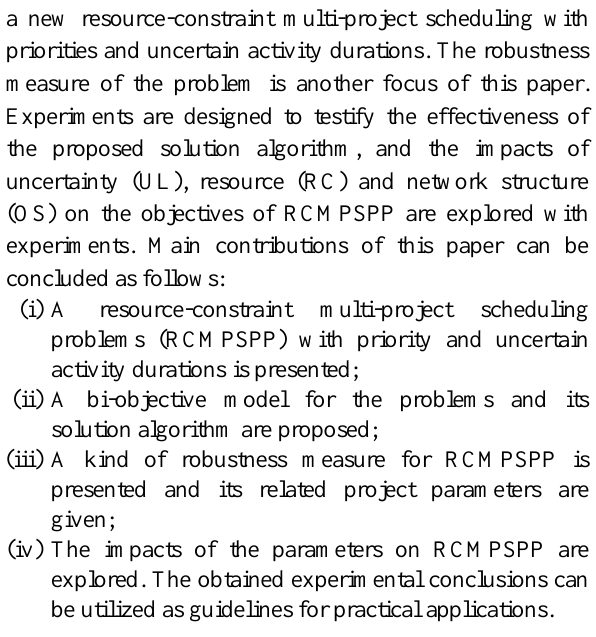
Fig.18 Impacts of RC and OS on